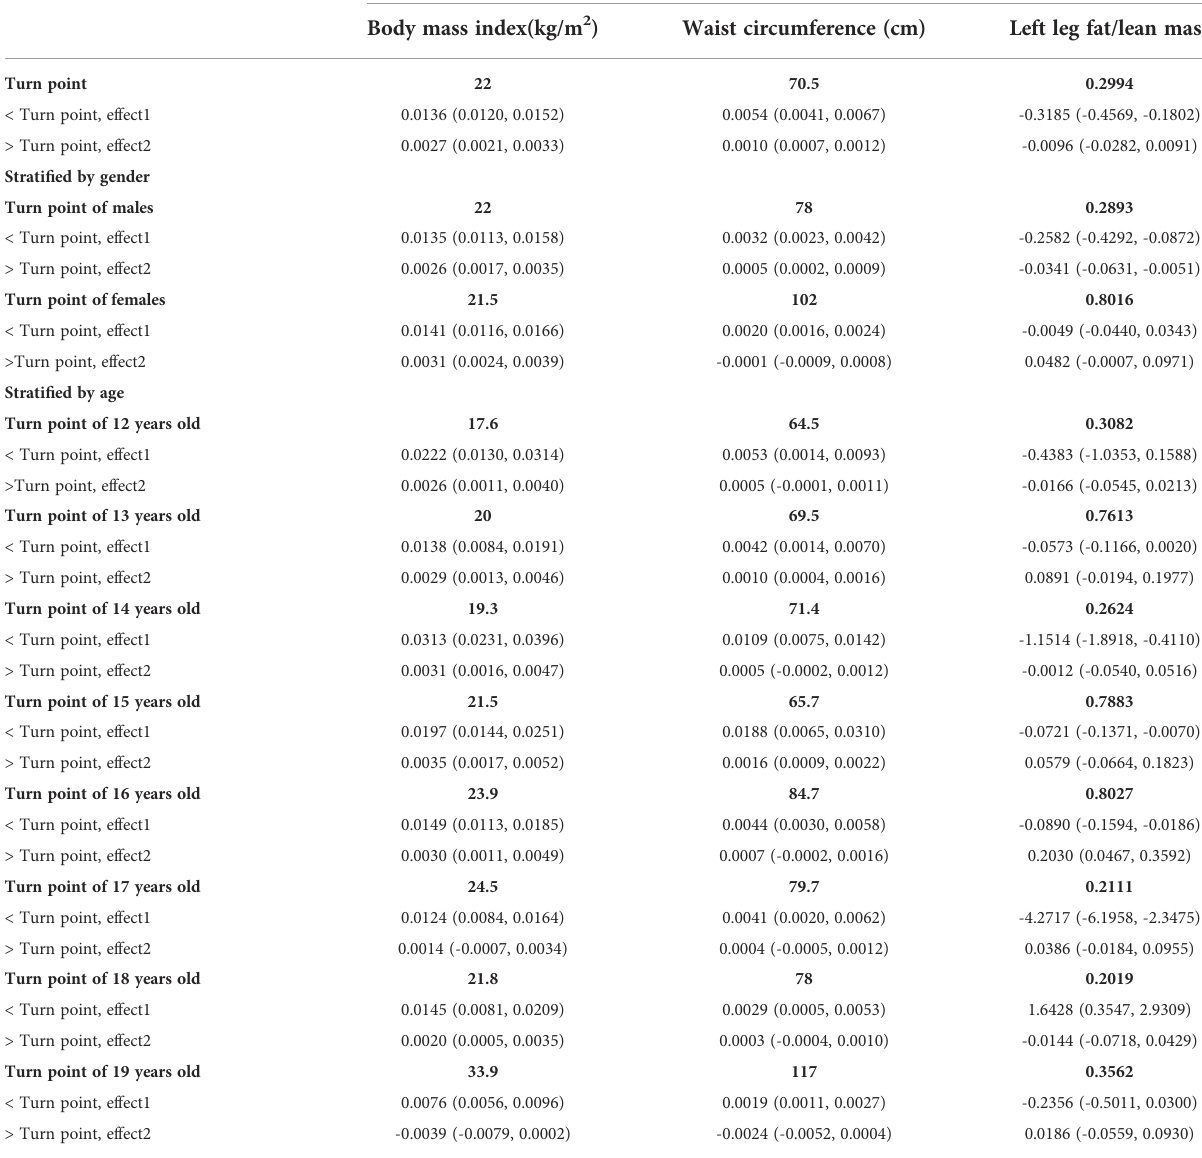
TABLE 3 Saturation effect analysis of obesity status and bone mineral density (g/cm 2